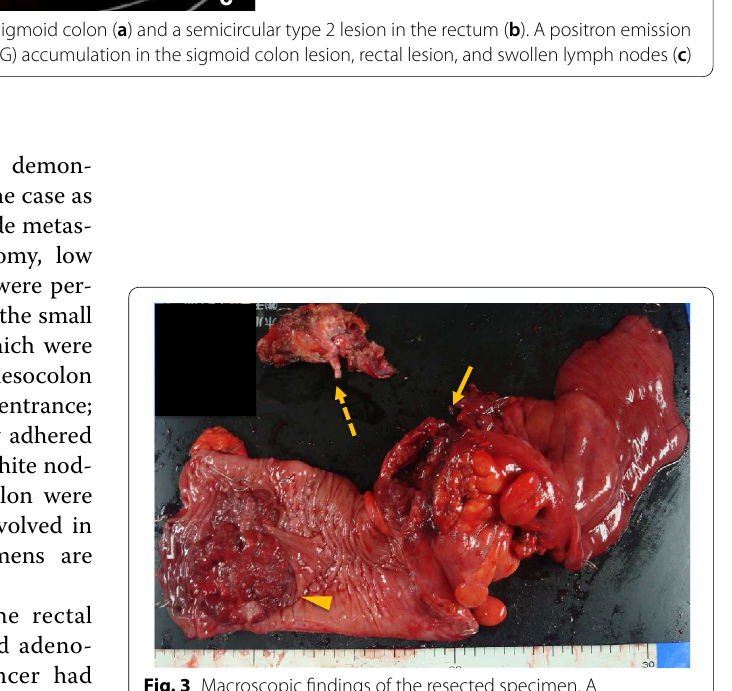
Fig. 3 Macroscopic findings of the resected specimen. A circumferential type 3 lesion was found in the sigmoid colon (arrow), and a semicircular type 2 lesion was found in the rectum (arrowhead). The sigmoid colon lesion invaded the small intestine, vas deferens (dashed arrow), which were resected